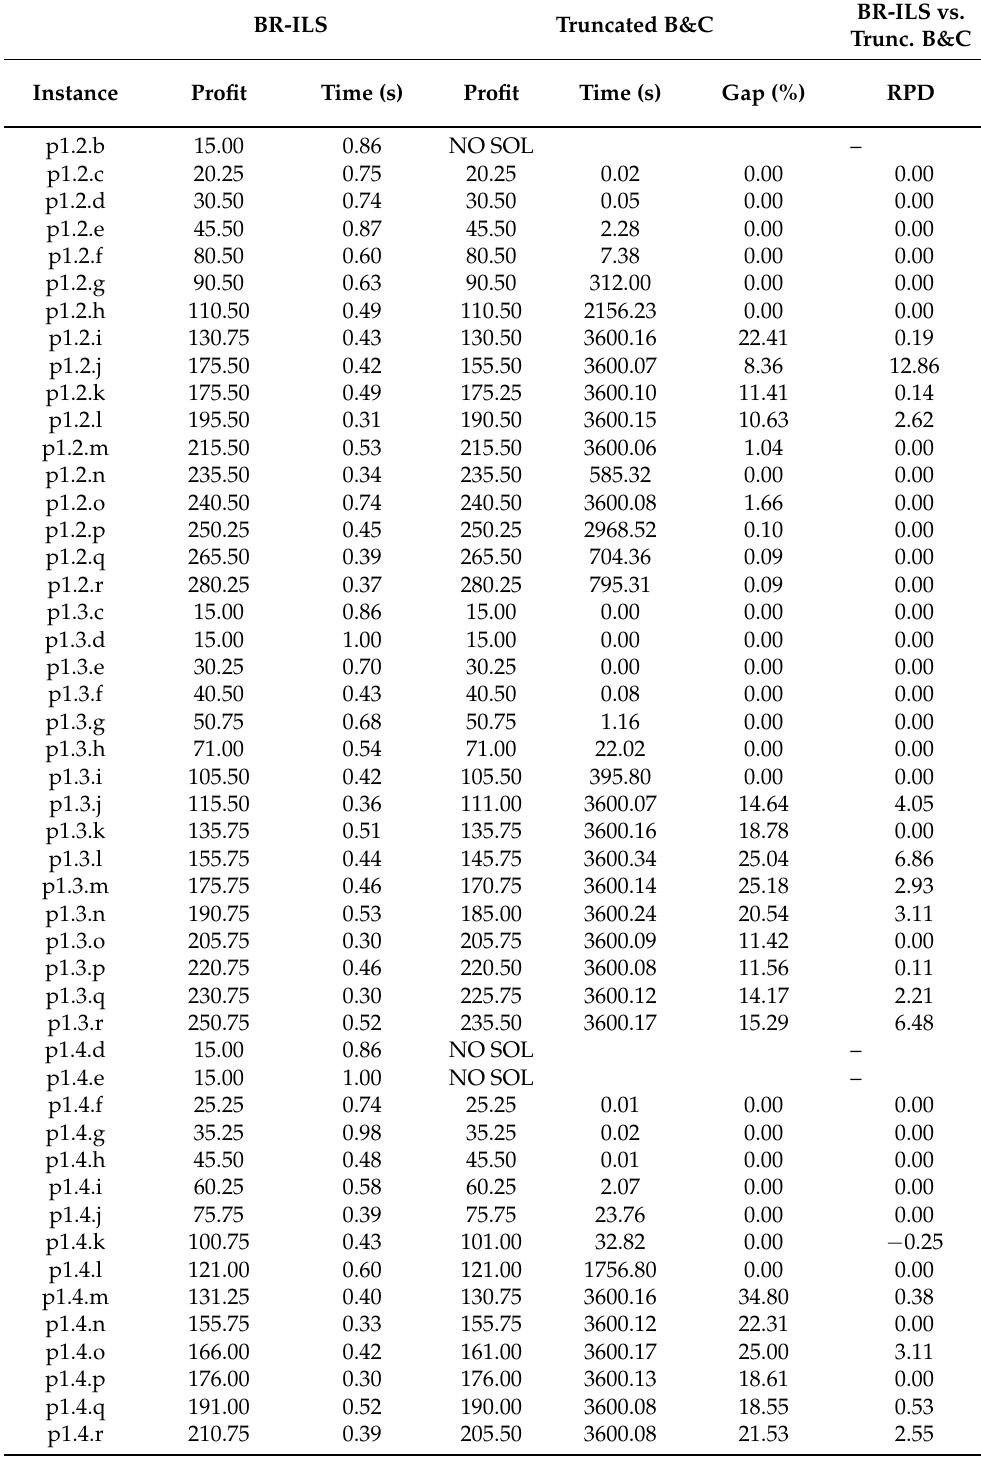
Table 2. Results given by the BR-ILS and the truncated B&C ( F 2) models for p 1